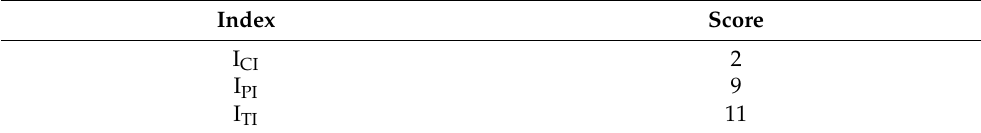
Table 3. Total inherent safety index.